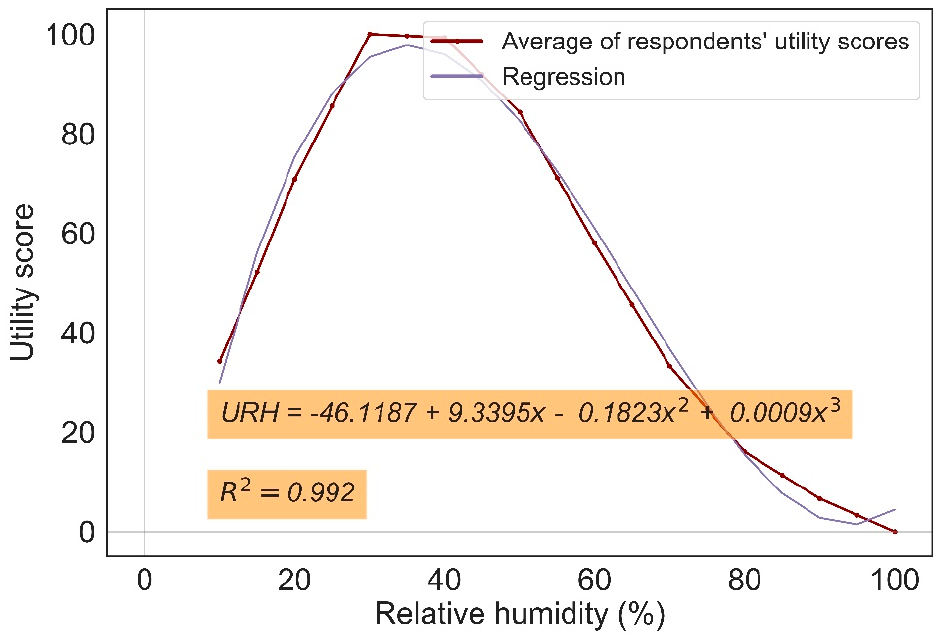
Figure 13. Empirical utility function for relative humidity in urban tourism.